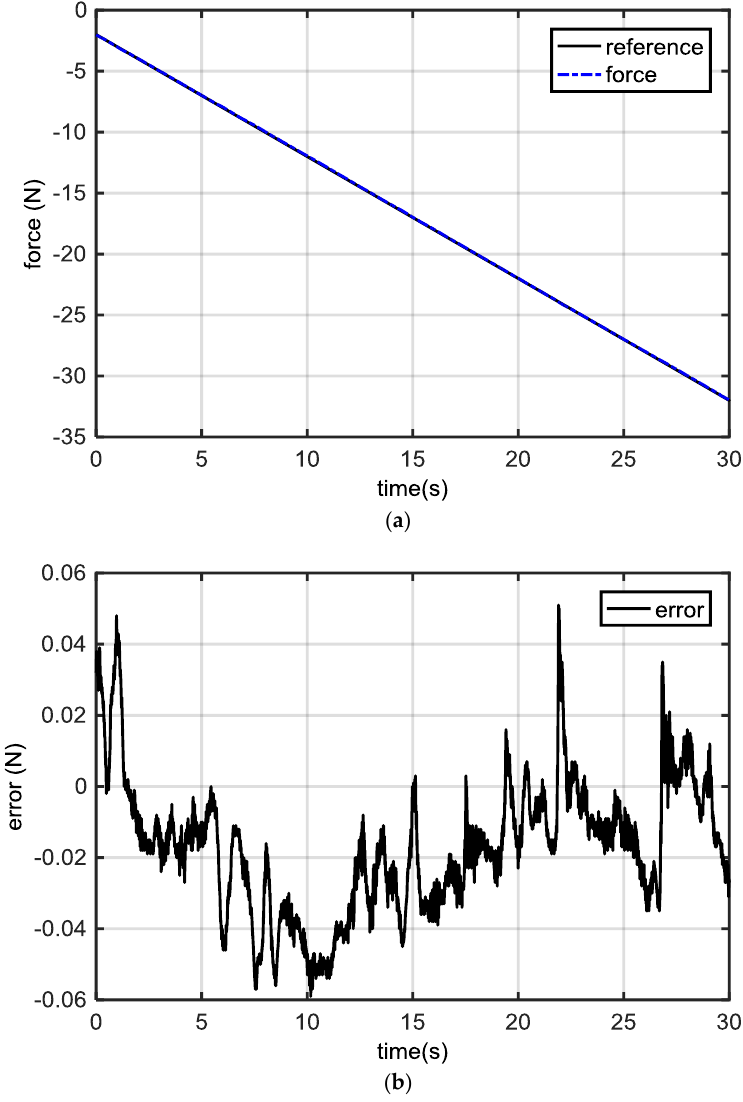
Figure 9. Dynamic response under constant proportion allocation with a saturation interval and error compensation scheme: ( a ) force profiles; ( b ) error waveforms.